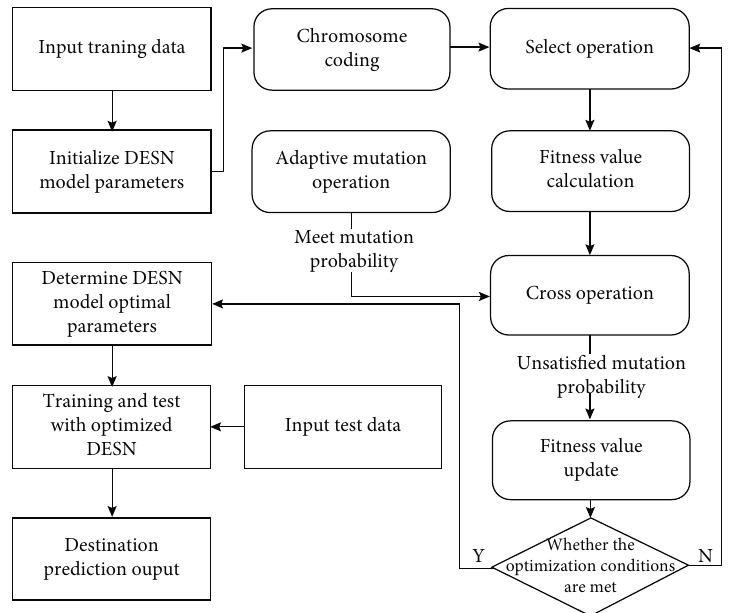
Figure 4: Process for implementing AGADESN algorithm.